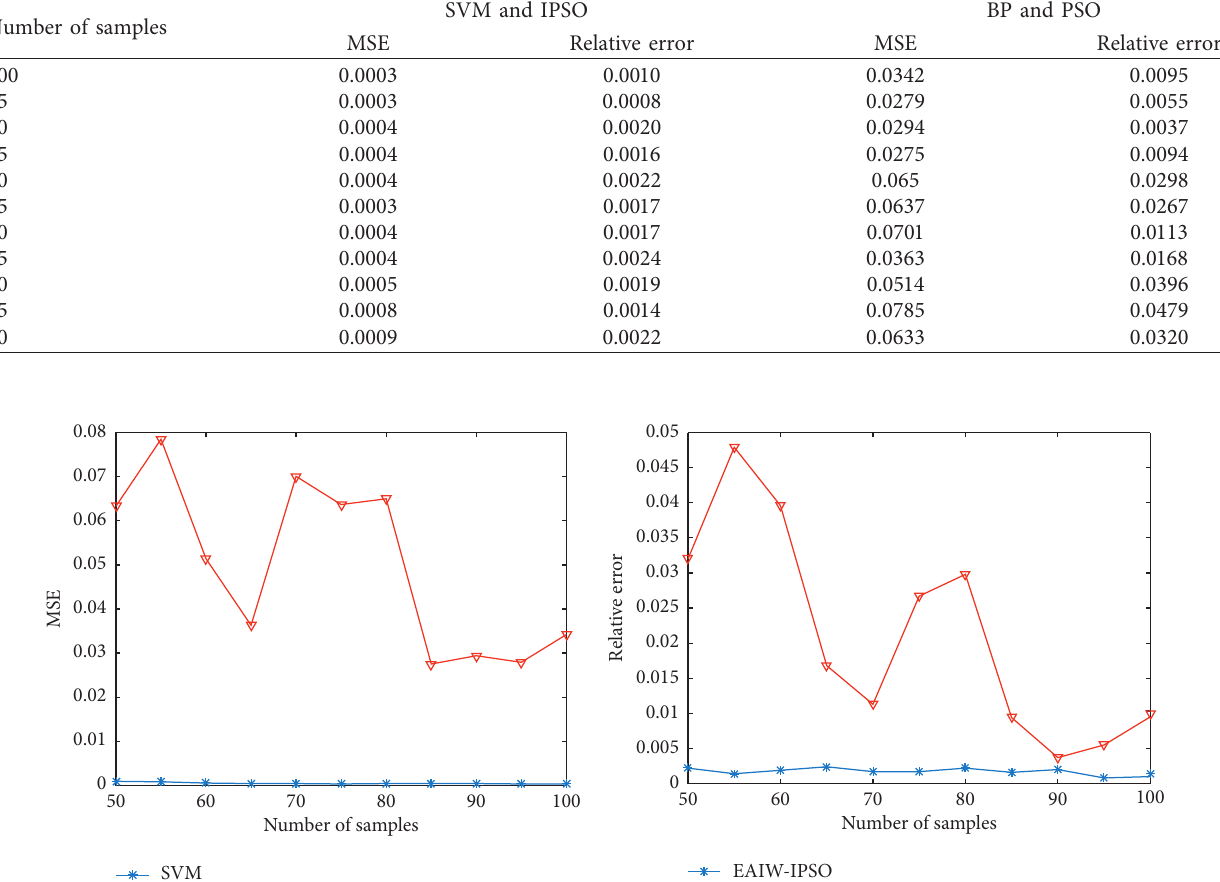
Table 2: Experimental results of the two models for the second case.